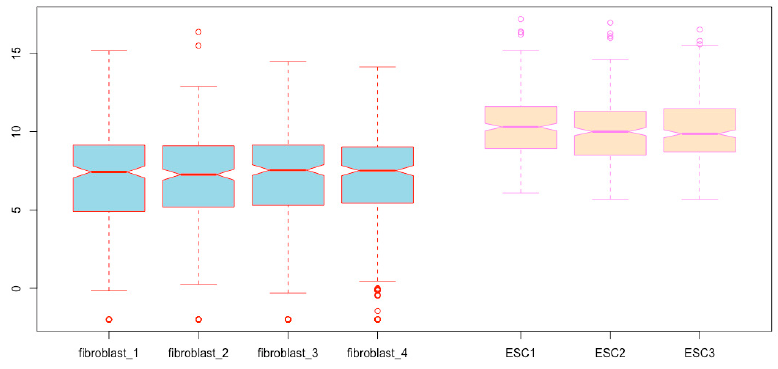
Figure 12. Spatially separate boxplots of different cell types.